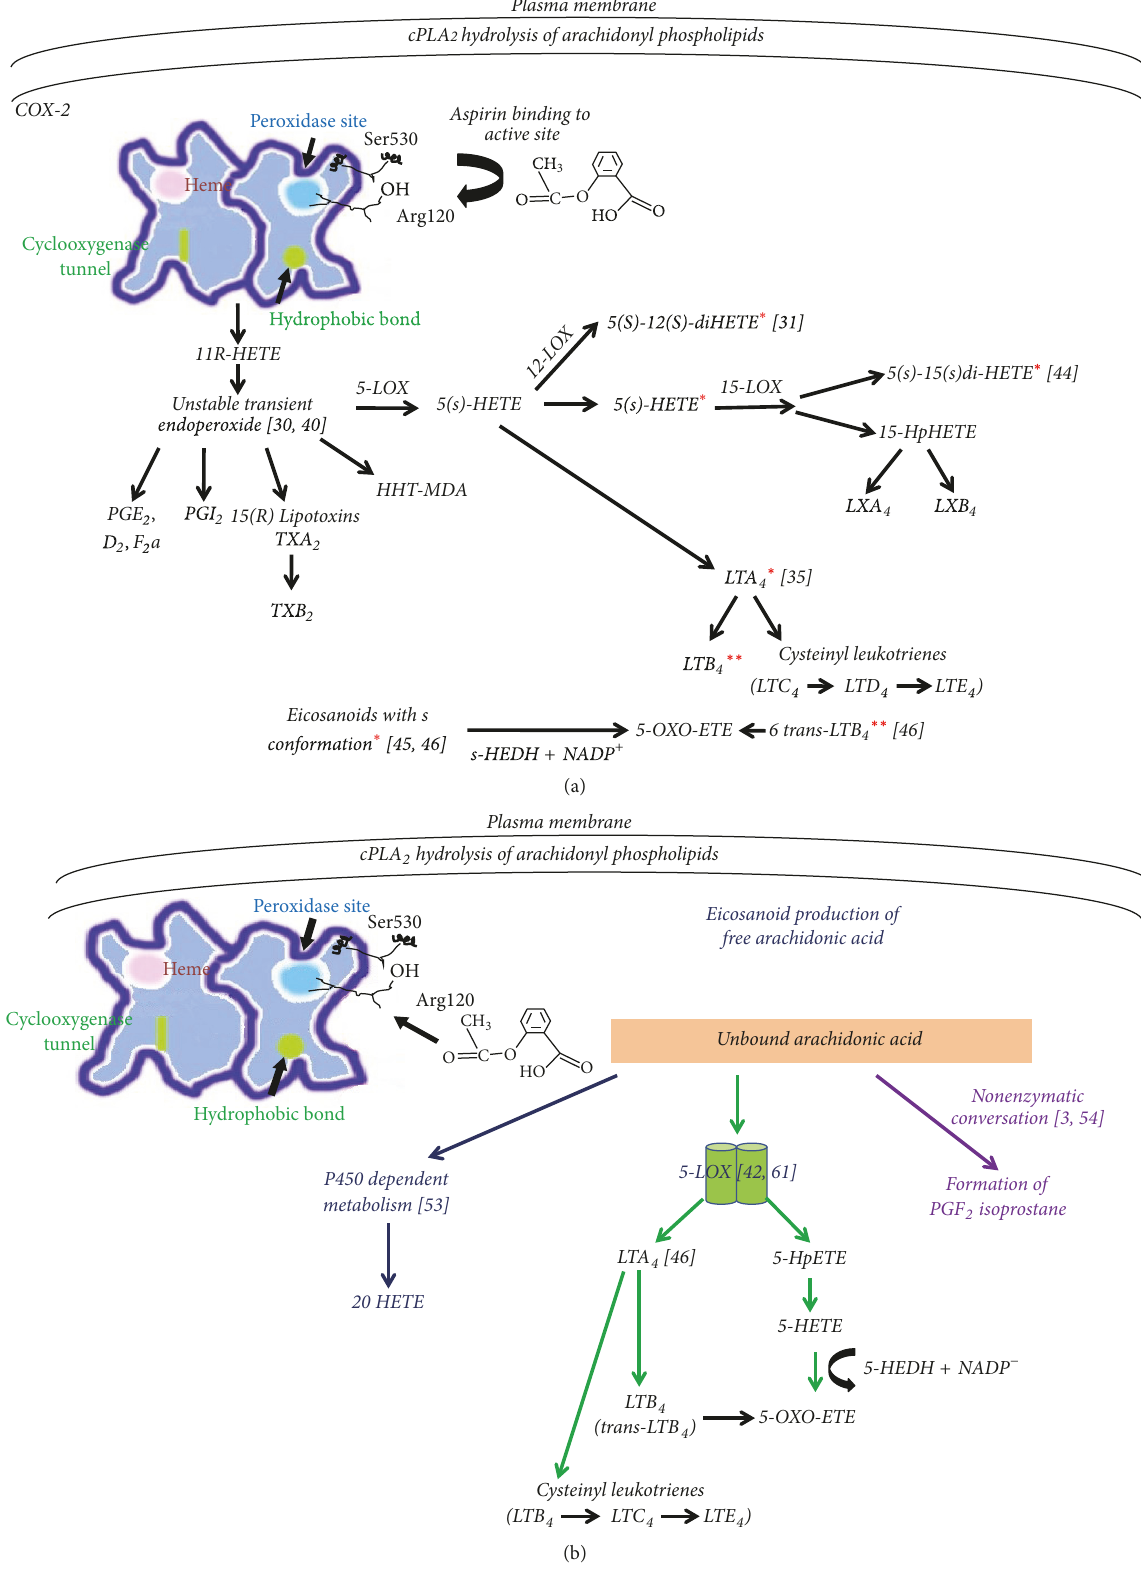
Figure 3: Metabolic events that follow acetylation of COX-2 and further transcellular activities: (a) eicosanoid production by crossover pathways of acetylated COX-2 and LOX isoenzymes [31, 35, 37–44]. (b) Eicosanoid production by free arachidonic acid [3, 44–46, 53, 54,